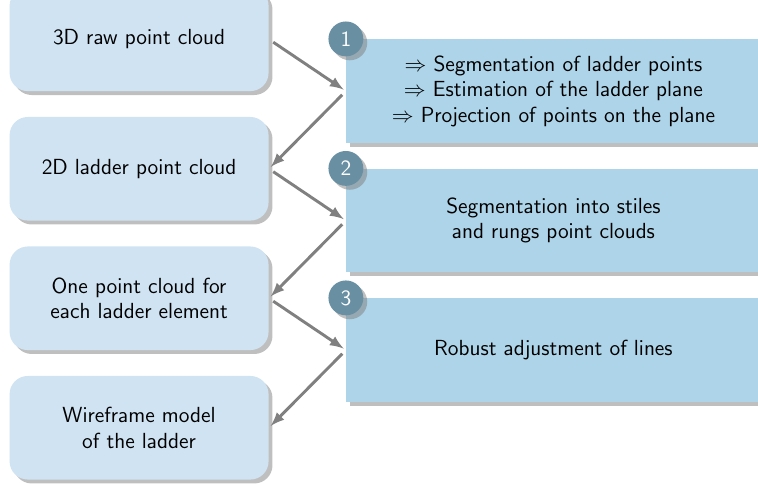
Figure 15. Flow chart of the ladder adjustment